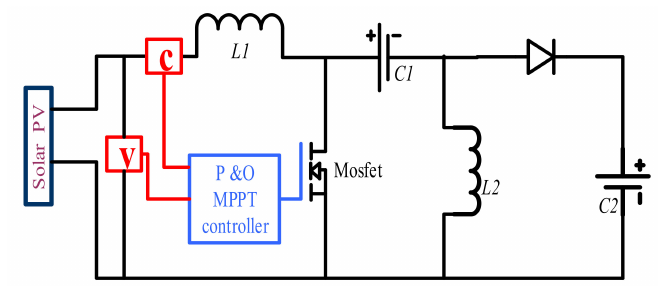
Figure 9. P&O-based MPPT boost converter